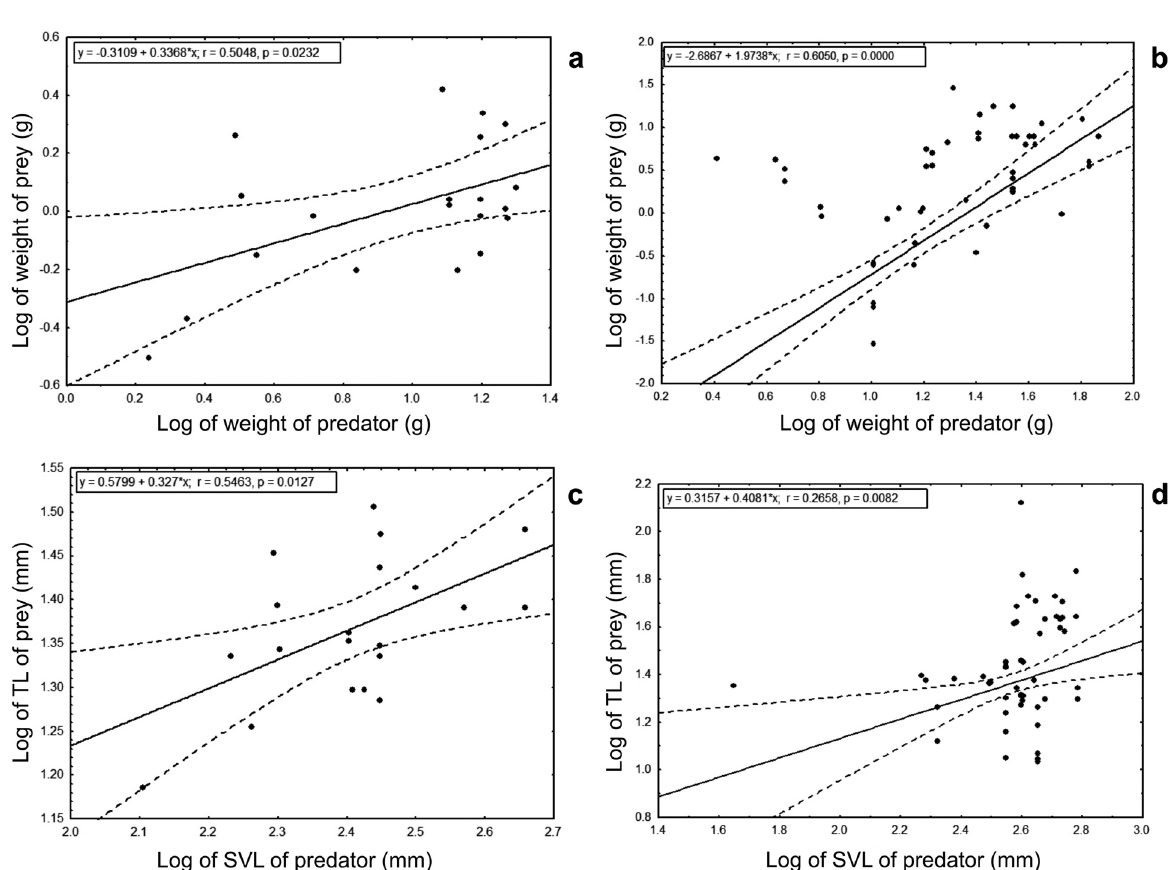
Figure 2 - Linear regression of prey weight as a function of predator weight for Erythrolamprus jaegeri jaegeri ( a ) and Erythrolamprus poecilogyrus sublineatus ( b ); linear regression of prey total length (TL) as function of predator snout-vent length (SVL) for Erythrolamprus jaegeri jaegeri ( c ) and Erythrolamprus poecilogyrus sublineatus ( d